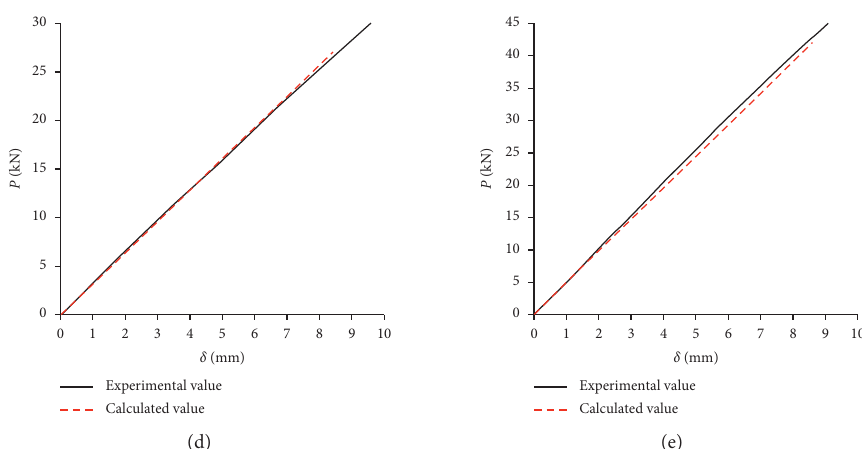
Figure 11: Comparisons of midspan deflections between the experimental and calculated value (in serviceability limit state). (a) B-1. (b) B-2. (c) B-3. (d) B-4. (e) B-5. Table 5: Comparison of flexural bearing capacities between calculated and experimental values.